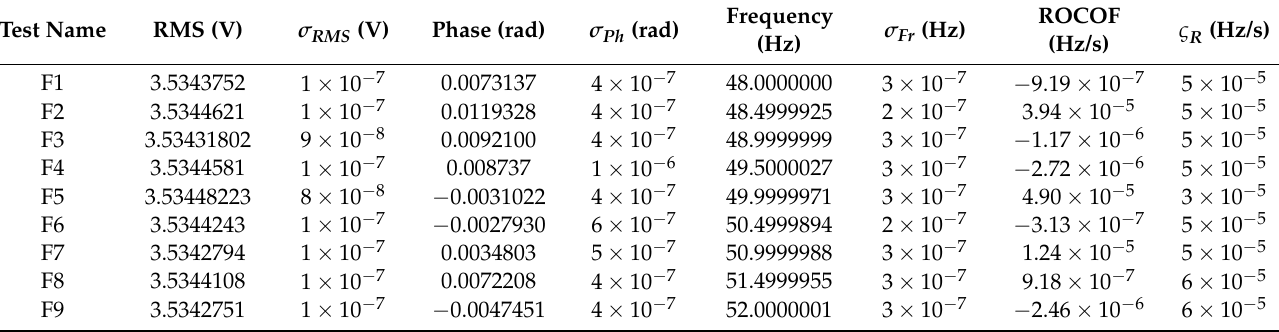
Table 16. Measurement results of the frequency